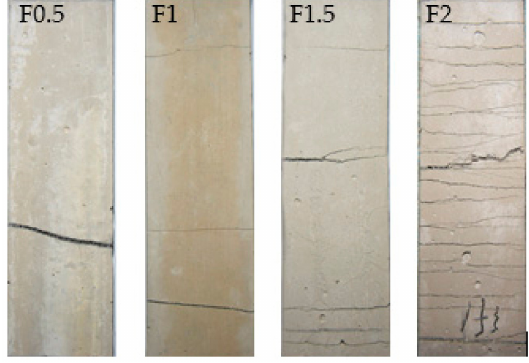
Figure 8. Crack pattern under uniaxial